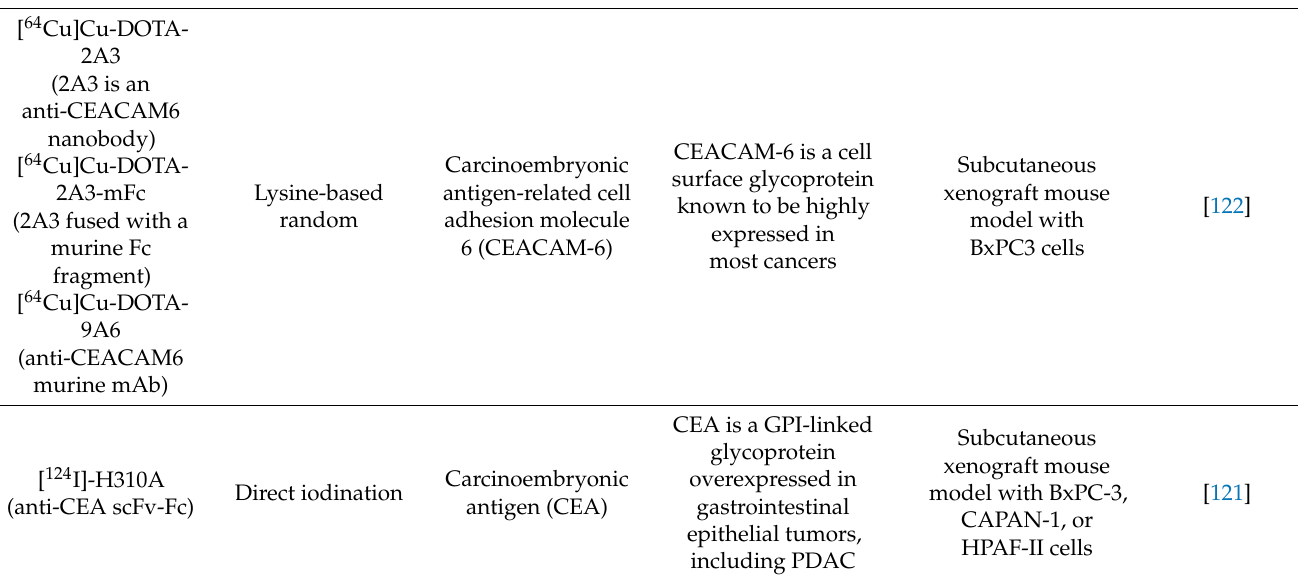
Antibody-based PET imaging probes for PDAC ordered by the most recent publication date. Bioconjugation strategy has been categorized into three methods: lysine-based random, site-specific via sortase-mediated reaction, and direct iodination. Antibody-based PET imaging probes reaching clinical trials are highlighted in